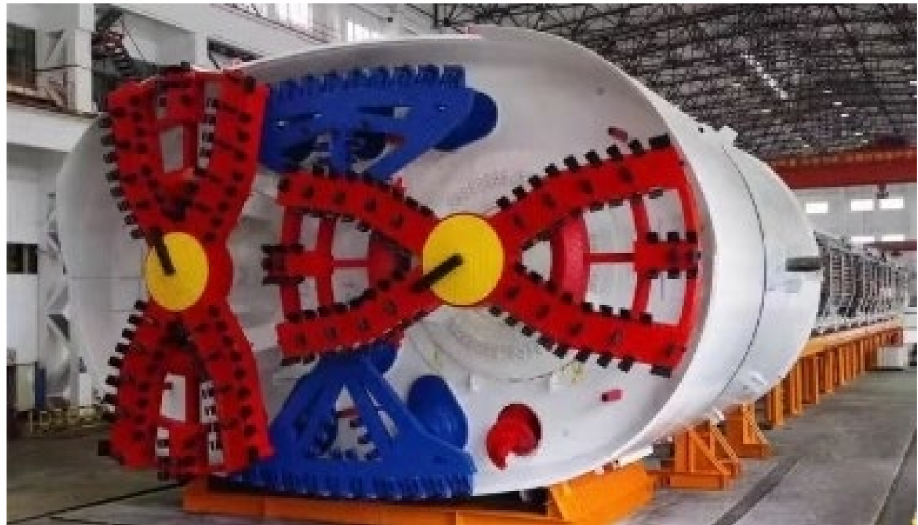
Figure 1. Quasi-rectangular EPB shield machine.